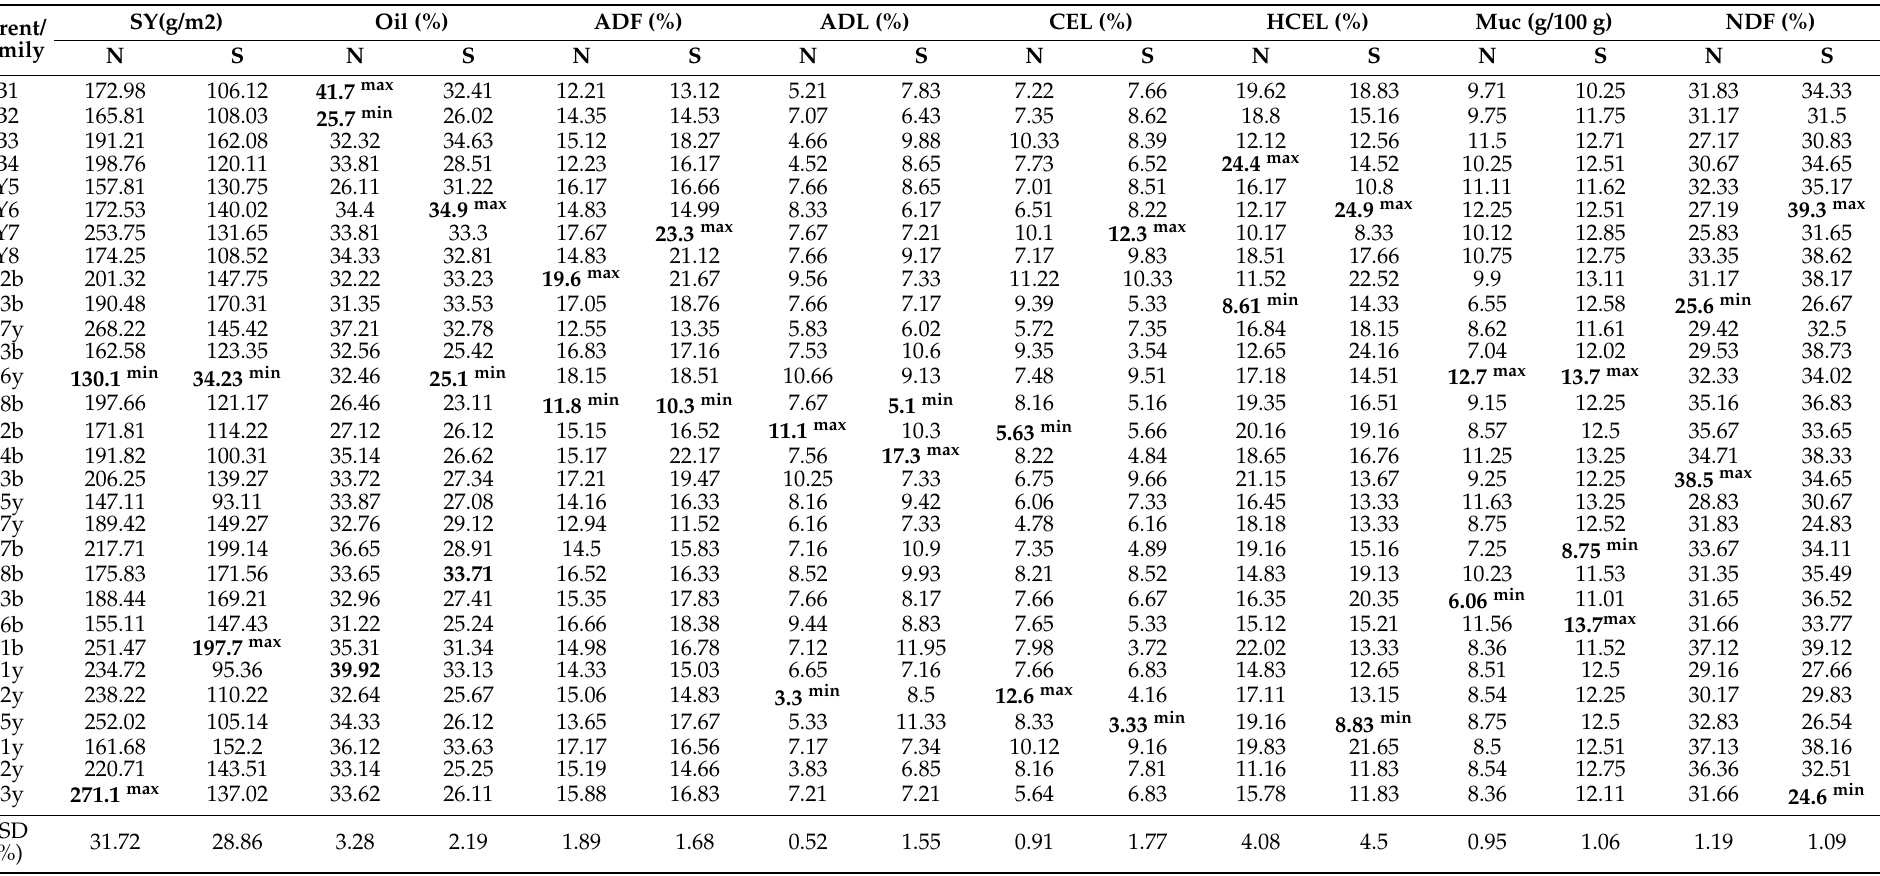
Table 3. Means of quality traits in parents and families of flax under control and intense drought stress